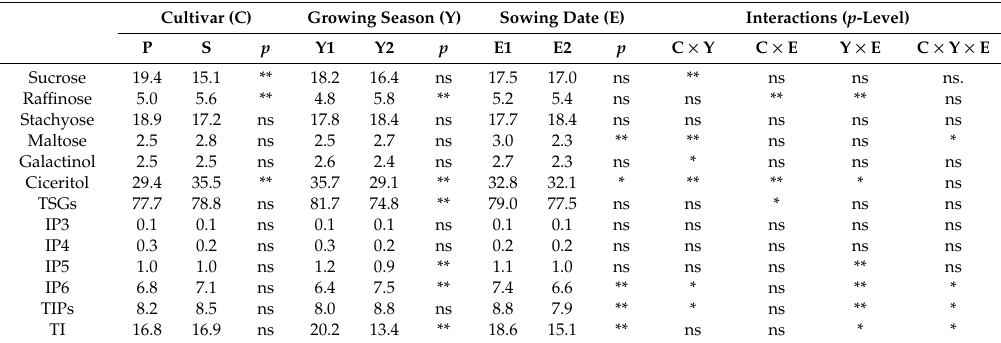
Table 1. Trial 1: E ff ects of cultivar (Pasci à versus Sultano), growing season (Y1 versus Y2), and sowing date (E1 versus E2) on the content of galactosides and inositol phosphates (g kg − 1 DM), and trypsin inhibitors (TIU mg protein − 1 ) in chickpea